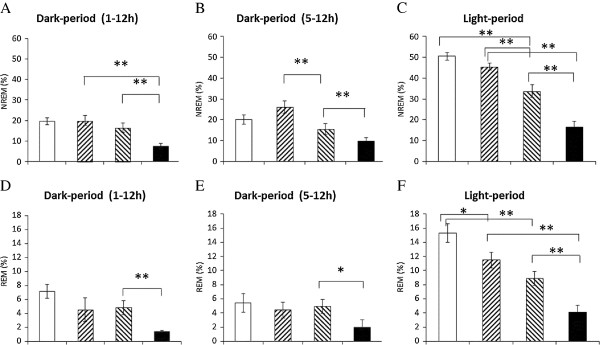
The summary of the effects of 100 Hz EA stimulation and pilocarpine in sleep. The bars from the left to the right in each panel represent the data acquired from the baseline, the EA group, the pilocarpine group and the PFS + EA + pilocarpine group. Panels A, B and C represent the percentage of time spent in NREM sleep during the 12-h dark period, the time block between 5-12 h of the dark period, and the 12-h light period, respectively. Panels D, E and F indicate the percentage of time spent in REM sleep during the 12-h dark period, the time block between 5-12 h of the dark period, and the 12-h light period, respectively. **: p < 0.01.